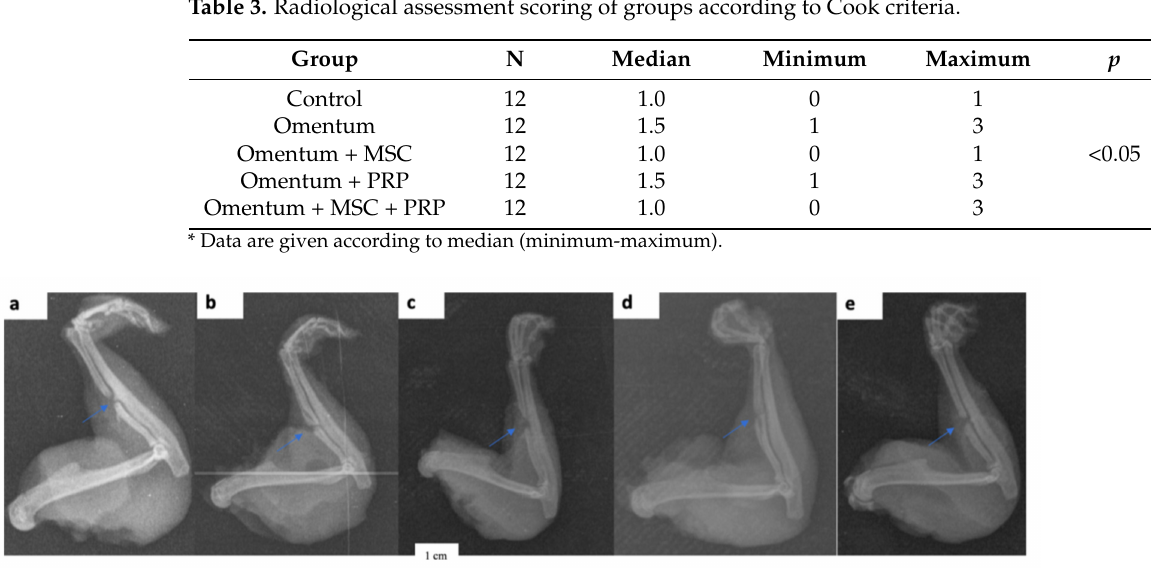
Figure 2. Radiologic samples of the groups. ( a ) Control group. ( b ) Omentum group. ( c ) Omentum + Mesenchymal stem cell group. ( d ) Omentum + PRP group. ( e ) Omentum + Mesenchymal stem cell + PRP group. * Blue arrows show the defective area.